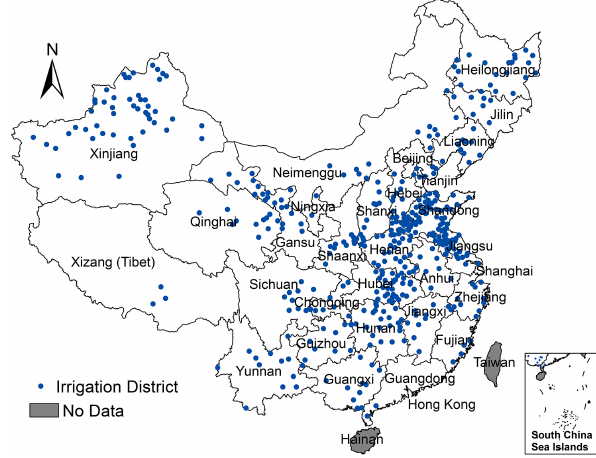
Figure 1. Distribution of 442 irrigation districts in 30 investigated provinces in